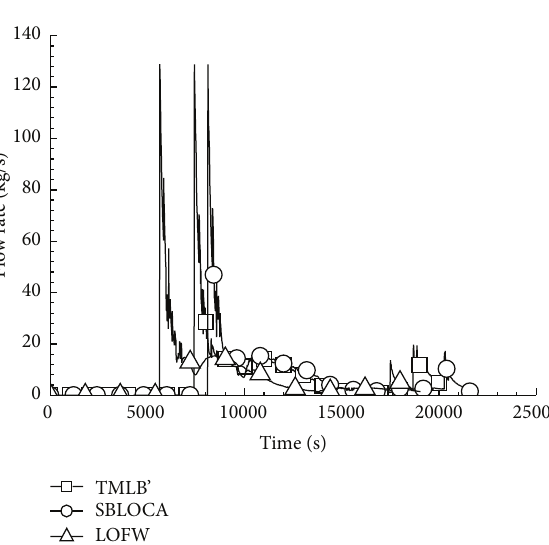
Figure 5: Highest core temperature without activation of SADV.